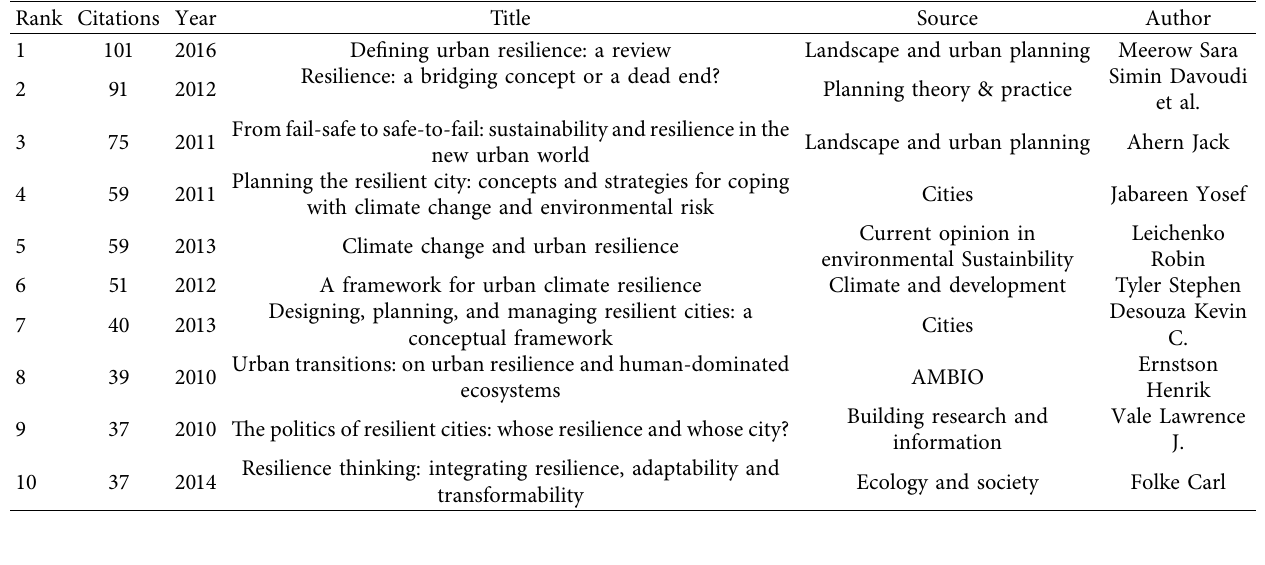
Table 1: Top 10 cited references in the resilient city field from 2010 to 2019.